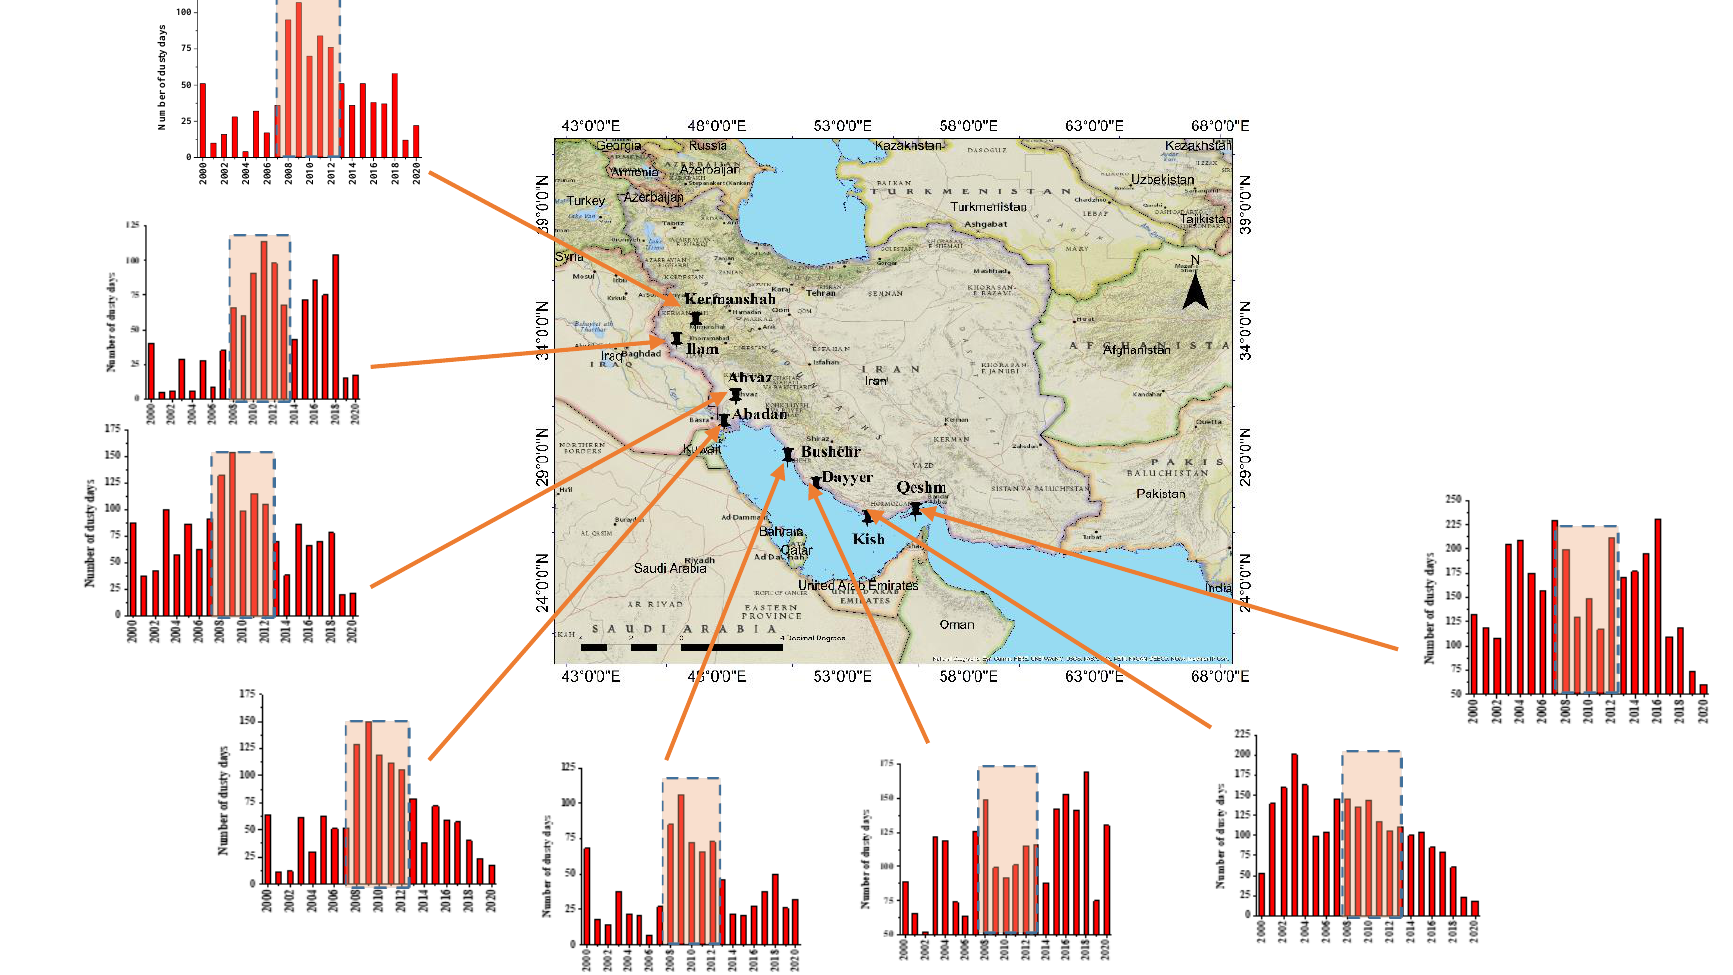
Figure 2. Annual variation of the number of dust days at 8 stations in west, southwest, and south Iran from 2000 to 2020.